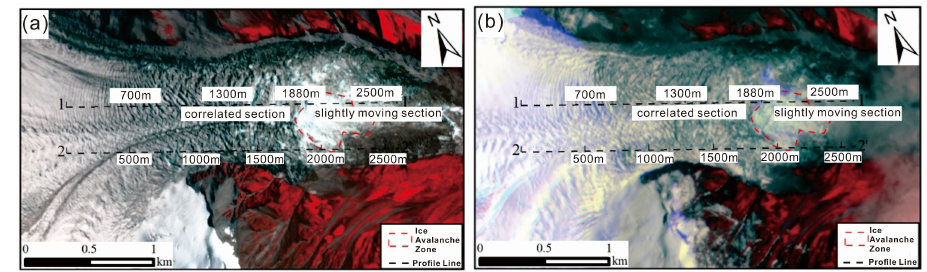
Figure 13. Planet satellite images of the ice cascade ( a ) before and ( b ) after the Luding